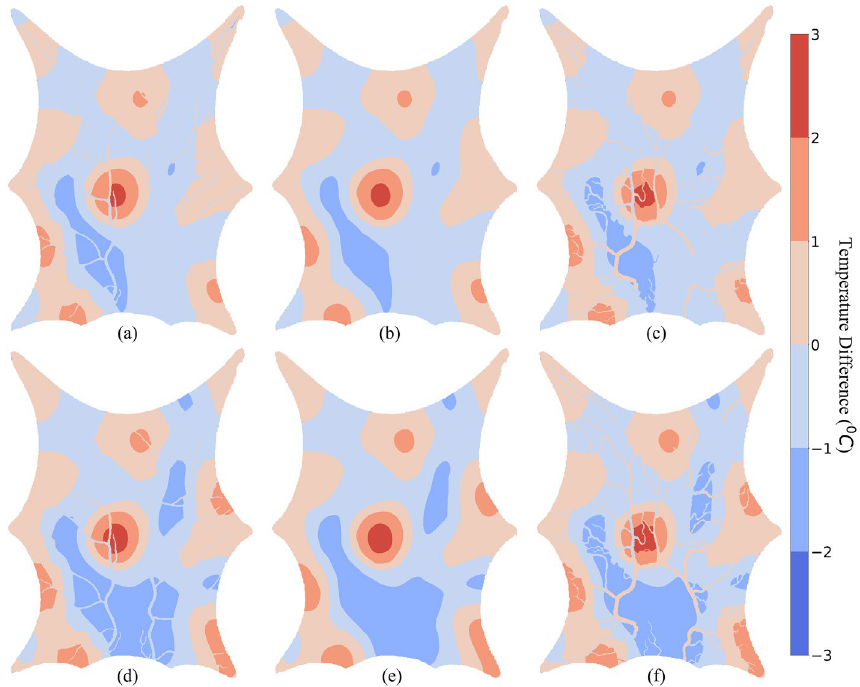
Figure 11. Temperature difference between ǫ = 5mm and ǫ = 10 mm. The positive temperature difference shows the region which are warmer when ǫ is smaller. h b = 10 W m − h